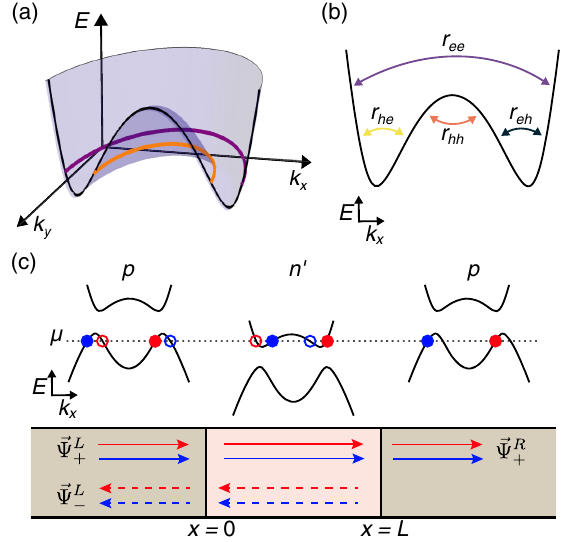
FIG. 3. (a) Sombrero-hat dispersion E ð k x ; k y Þ of the hybridized conduction band resulting from the theoretical model, Eq. (2), as applied to the InAs/GaSb system. (b) Overview of the scattering processes ij that occur within the n 0 -doped cavity when a quasiparticle impinges onto the interface between cavity and lead. The r ij are reflection coefficients. (c) Upper panel: band structure in the three regions of a pnp junction. The dashed horizontal line represents the electrochemical potential μ . Full blue (red) circles represent holelike (electronlike) states moving to the right, while empty blue (red) circles represent holelike (electronlike) states moving to the left. Lower panel: sketch of a Fabry-Perot interferometer for a one-dimensional channel. The colors are coded according to the upper panel, with red (blue) arrows denoting holelike (electronlike) states moving to the right (solid lines) and left (dashed